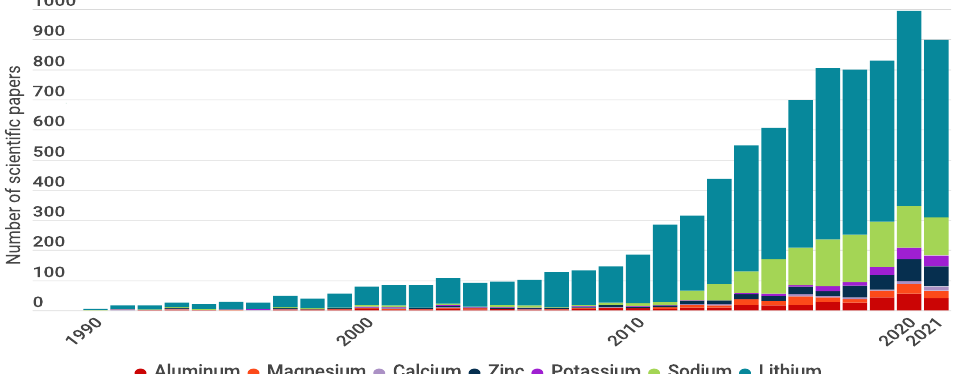
Figure 9. Publications per year about positive electrodes, comparing seven battery types: Li, Na, K, Zn, Ca, Mg, and Al. Graph constructed by the authors. Data from Web of